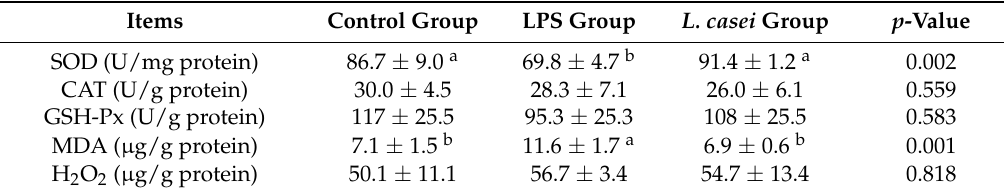
Data are means ± SD, n = 6. MDA = malondialdehyde; H 2 O 2 = hydrogen peroxide; SOD = superoxide dismutase; CAT = catalase; GSH-Px = glutathione peroxidase. Control group = piglets fed the basal diet and received administration of saline; LPS group = piglets fed the basal diet and challenged with LPS; L. casei group = piglets fed the basal diet supplemented with 6 × 10 6 cfu/g L. casei and challenged with LPS; a,b Values within a row with different superscript letters differ significantly ( p < 0.05).